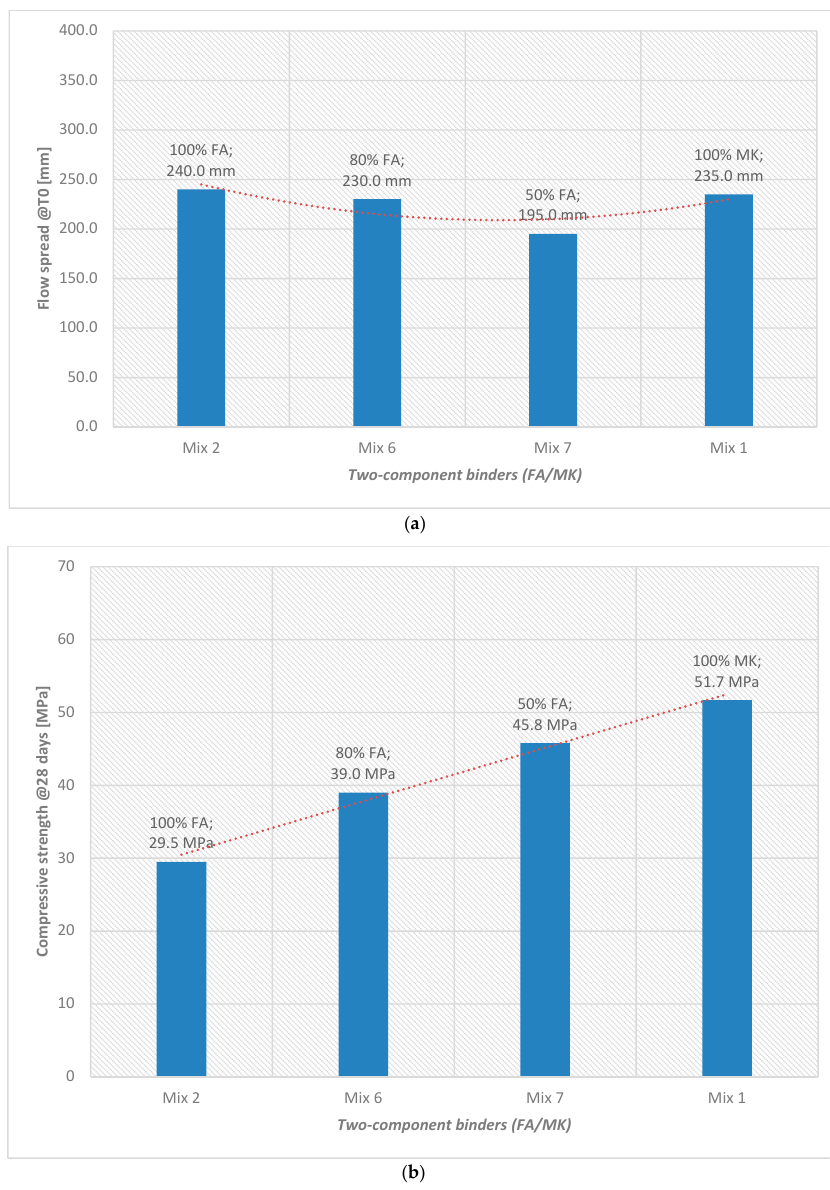
Figure 5. Technical performance comparison for mortars based on fly ash/metakaolin blends: ( a ) flow spread and ( b ) compressive strength at 28 days.